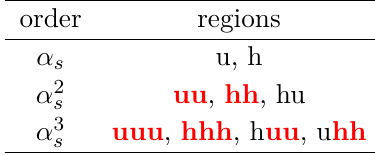
) : hard (h) and ultra-soft s